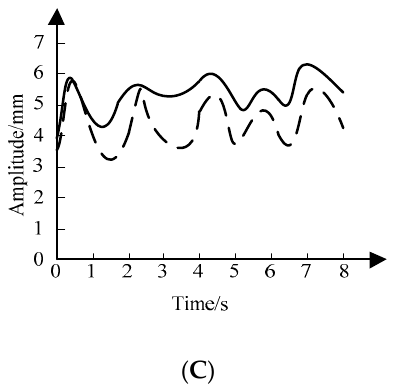
Figure 5. Comparison of control results of different algorithms. ( A ) Synchronous control algorithm based on fuzzy neural network. ( B ) Synchronization control algorithm based on multi-factor self-tuning fuzzy control. ( C ) Synchronization control algorithm based on improved fractional non-growth adaptive law.